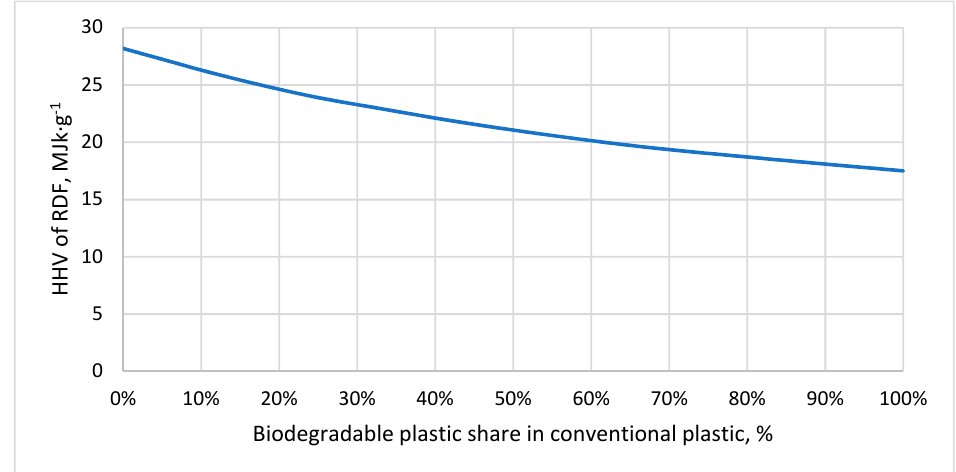
Biodegradable plastic share in conventional plastic, % Figure A1. Effect of biodegradable plastic share in conventional plastic on RDF quality. In Table A1, torrefaction temperature and time effect on process yields and fuel properties are summarized. Presented equations are valid for CSF properties determination at T = 200–300 °C and t = 20–60 min. The R 2 stands for the determination coefficient. The higher = better. Table A1. Empirical equations for determination of torrefaction process and fuel properties of CSF produced from PLA and PAP; the equations boundary, T = 200–300 °C, t = 20–60 min.